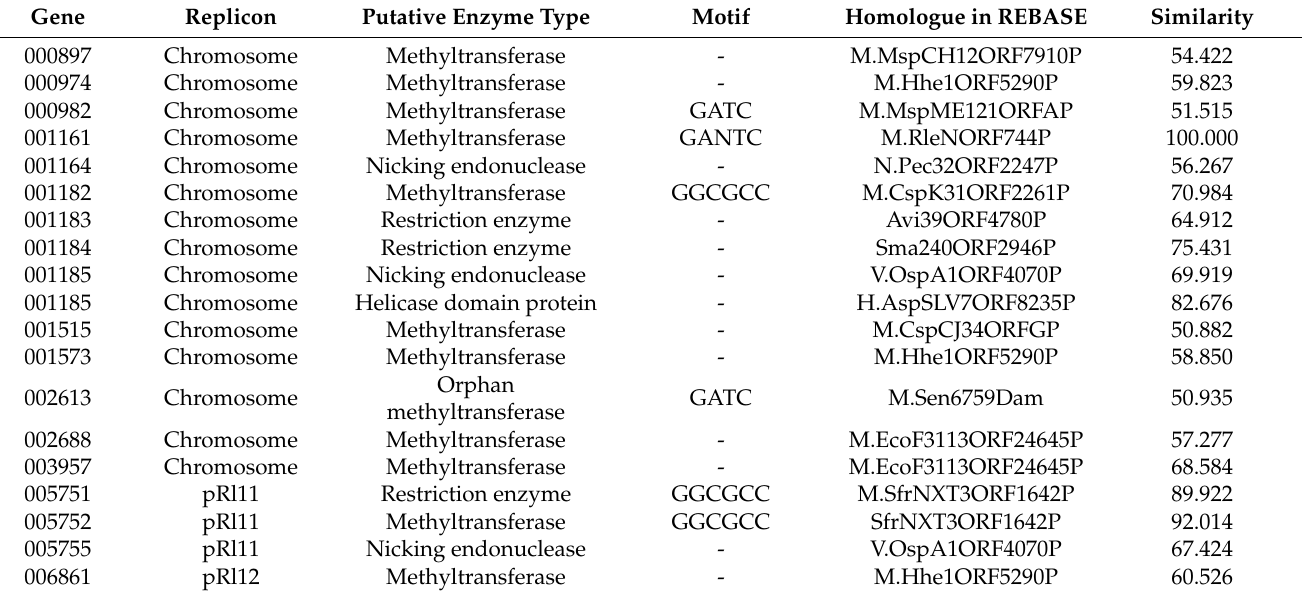
Table 4. Genome methylation systems in RCAM1026.